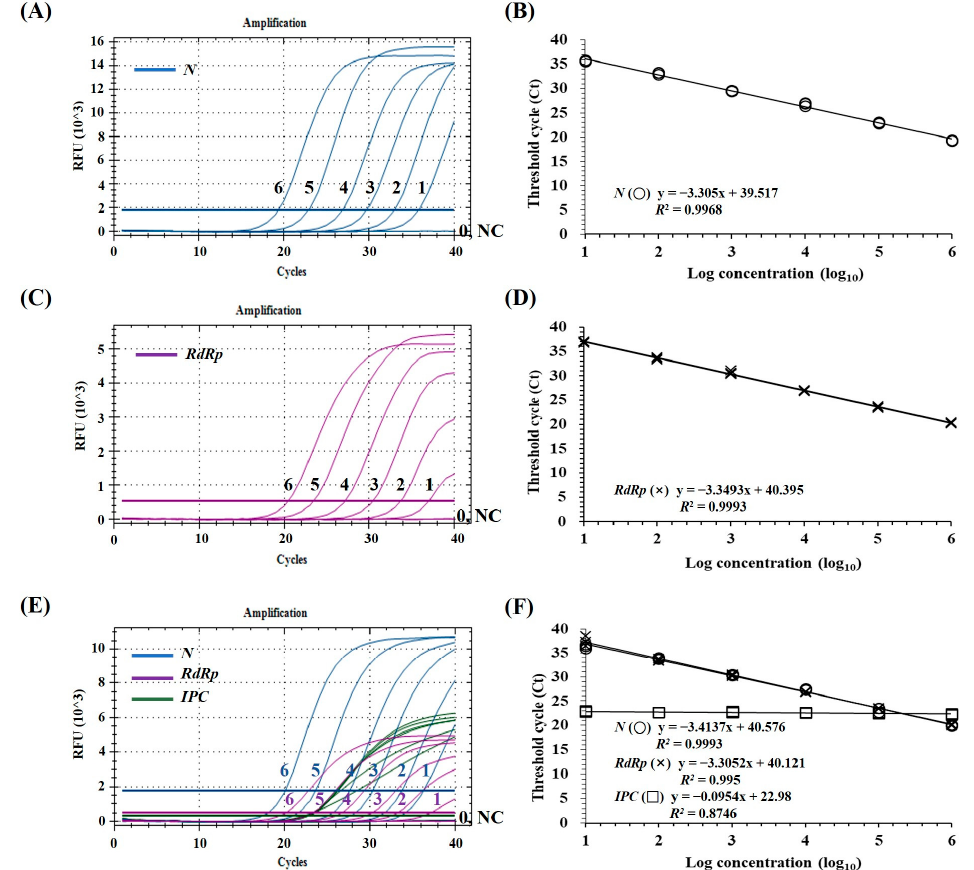
Figure 1. The limit of detection (LOD) and standard curve of the monoplex real-time RT-qPCR and multiplex real-time mRT-qPCR. The LOD and standard curve of the N and RdRp genes were obtained by monoplex RT-qPCR for 10-fold serial dilutions of SARS-CoV-2 standard RNA ( A – D ). The LOD and standard curves of mRT-qPCR for 10-fold serial dilutions of SARS-CoV-2 standard RNA are shown ( E , F ). Lines 6–0, 10-fold serial dilutions of the SARS-CoV-2 standard RNA (10 6 –10 0 copies); NC, negative control. The coefficient of determination ( R 2 ) and the equation of the regression curve (y) were calculated using the CFX Manager software (Bio-Rad).